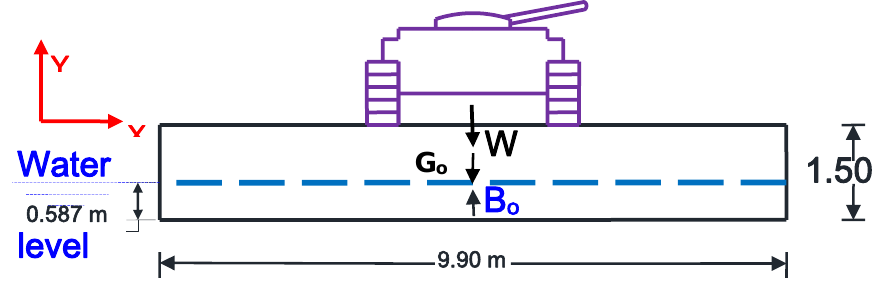
Figure 2. The loaded ferry under stability condition.